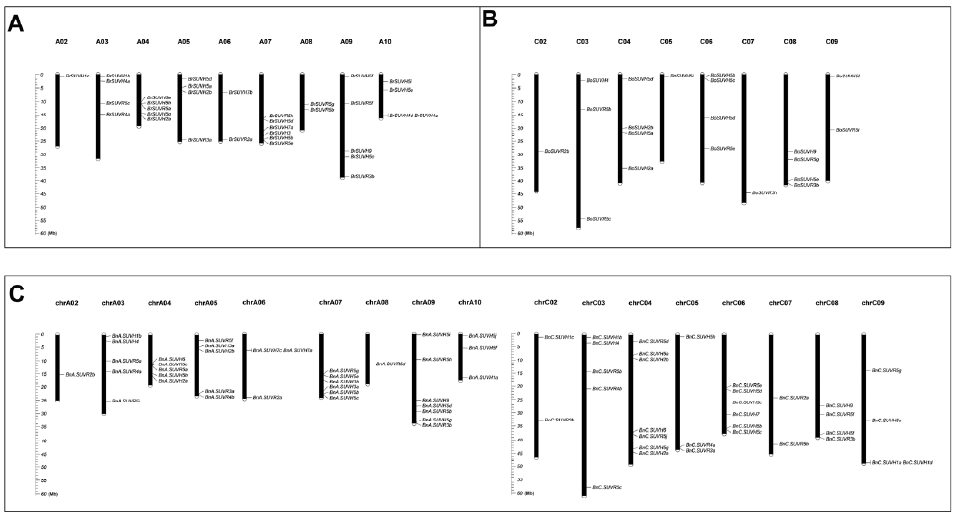
Figure 4. The chromosomal location of the SUV gene family in B. rapa ( A ), B. oleracea ( B ) and B. napus ( C ) .